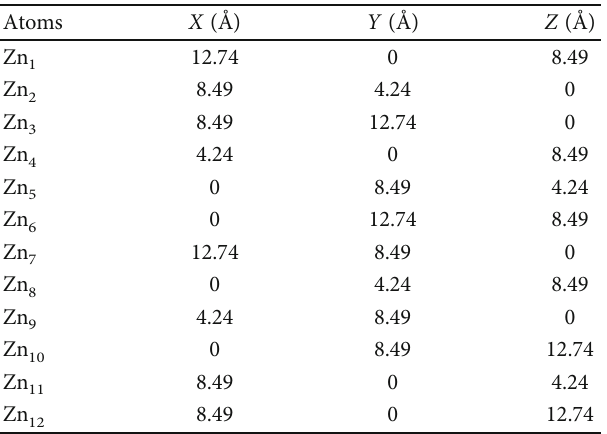
Figure 2: Top views of the atomic structure of the Zif-8 compound. The green, blue, pink, and black spheres represent C, N, H, and Zn atoms, respectively. Table 1: Atomic positon of Zn in Zif-8 compounds. Table 2: Calculated bond lengths, bond angle, and lattice constants of